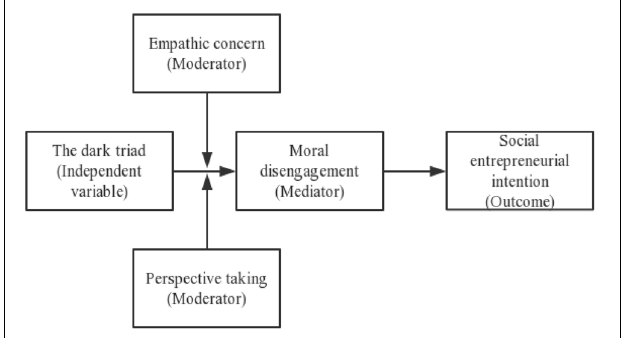
FIGURE 1 | The heuristic relationship of the study.